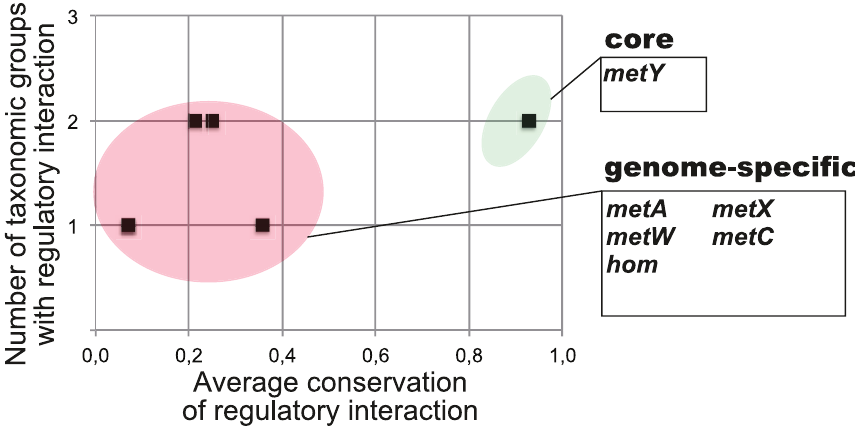
Figure 6. Conservation of regulatory interactions in the reconstructed SAM_alpha riboswitch regulons. The core regulon, taxon- and genome-specific regulon members are highlighted and listed along with their average conservation scores and functional annotations in Table S2.